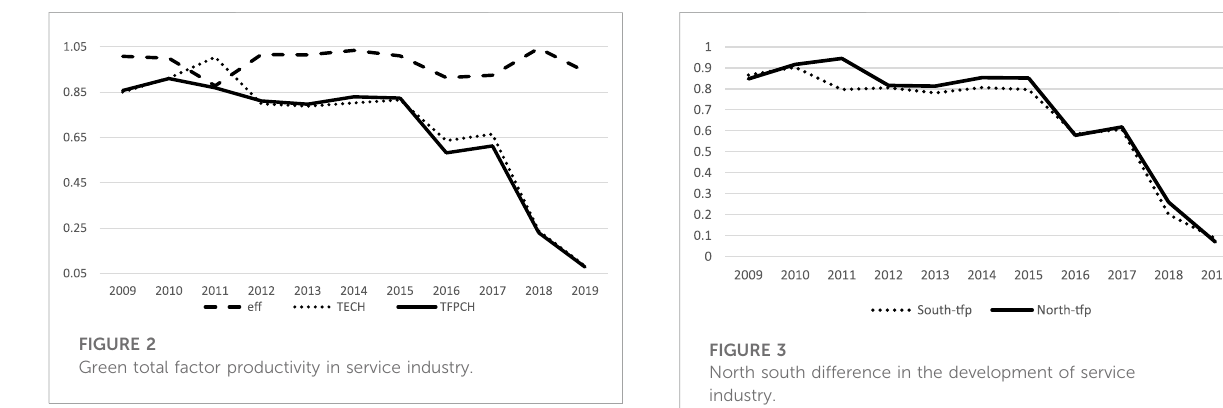
FIGURE 2 Green total factor productivity in service industry.